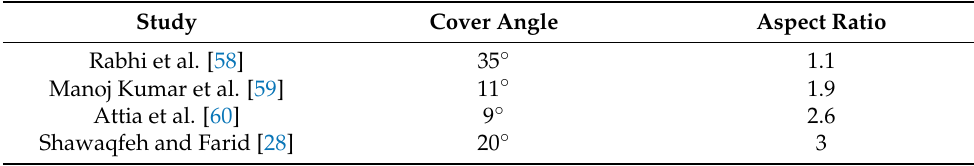
Table 1. Cover angle and aspect ratio for validation